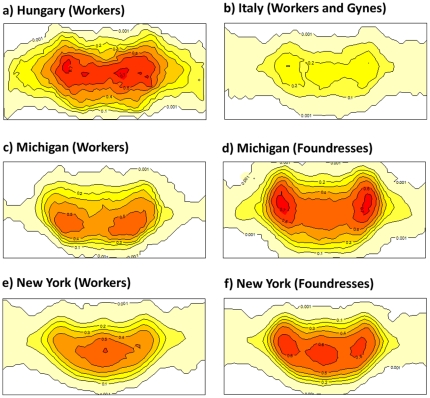
Contour maps of population-level clypeal melanin pigmentation in different groups of wasps.Each contour line represents the percentage of wasps in the population with pigment present in that region of the clypeus. These maps demonstrate that in general pigmentation is most common in central area of the face, that different locations have dramatically different population level patterns of pigmentation, and that workers tend to have less complex patterns than foundresses. Number of photographs used to create the contour maps: a) 42, b) 132, c) 87, d) 147), e) 425), f) 384.